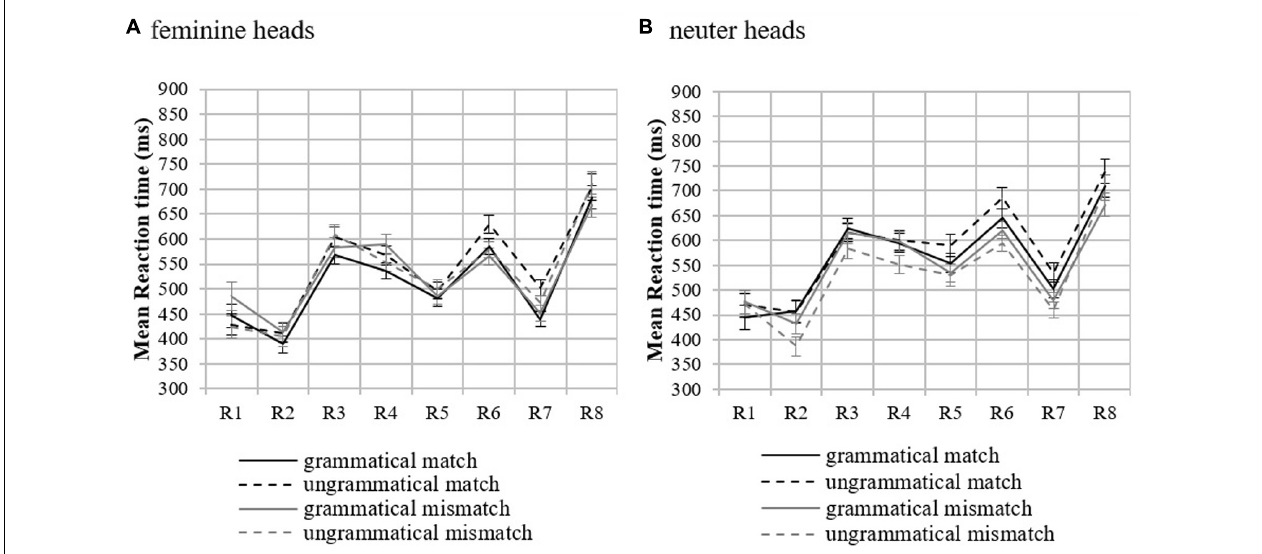
FIGURE 3 | Mean reaction time by condition in feminine (A) and neuter (B) heads in Experiment 2. Error bars indicate the standard error of the mean across participants. R on the x -axis stands for Region. Region 3 : Head, Region 4 : Attractor, Region 5 : Agreement target (past-participle), Region 6 : first post-critical region, Region 7 : second post-critical region and Region 8 : sentence-final